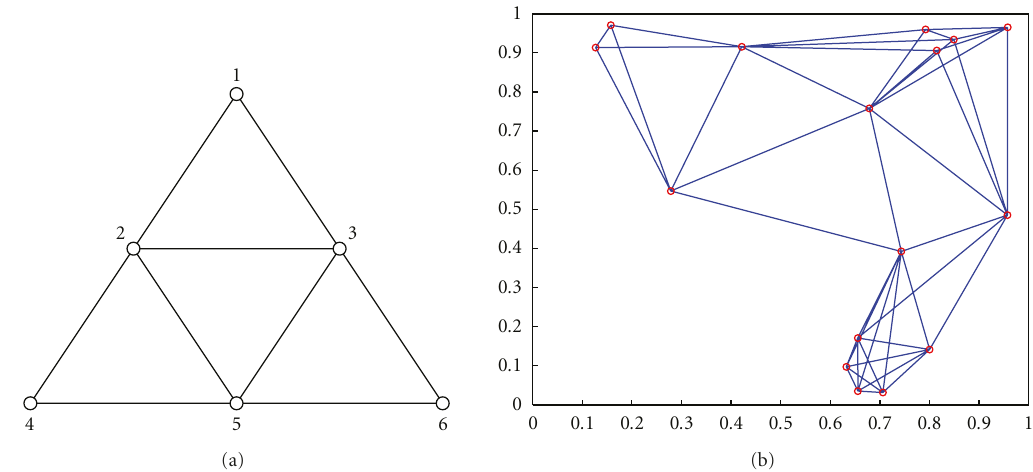
Figure 1: Network topologies used in numerical results: (a) fixed network with 6 nodes (Case 1) and (b) random network with 16 nodes (Case